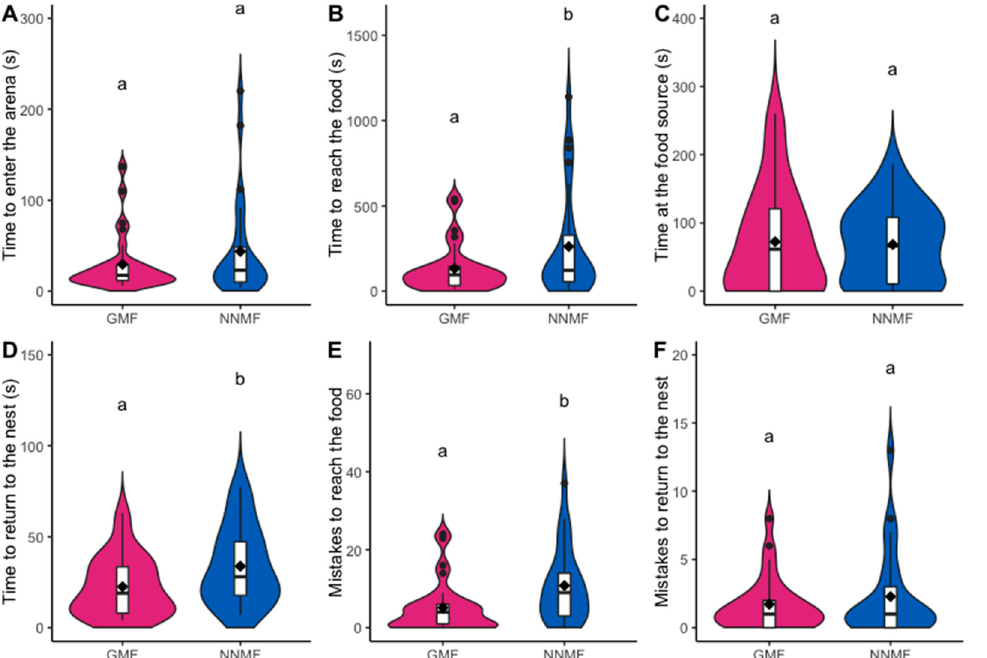
Figure 1. Foraging activity of Lasius niger under GMF and NNMF recorded during Phase 1. Violin plots show ( A ) the time spent by the first forager to enter the arena, ( B ) the time spent to reach the food source, ( C ) the time spent at the food source, ( D ) the time spent to return to the nest, ( E ) the number of mistakes made to reach the food source, and ( F ) the number of mistakes to return to the nest during Phase 1. The violin shape shows the distribution of the values, and the box plot inside is made by a black line in the center that indicates the median; the top and bottom of the black box represent the upper and lower quartiles; whiskers represent the maximum and minimum values, while the black dots indicate the outliers. Diamonds indicate mean values. Different letters indicate significantly ( p < 0.05) different values based on generalized linear mixed model results.